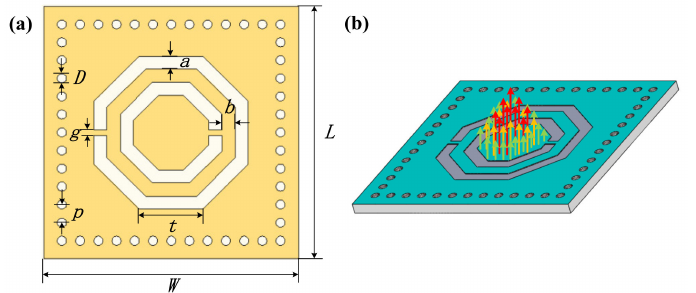
Figure 1. Model of the proposed CSRR integrated sensor. ( a ) The physical and geometric parameters of the CSRR integrated temperature sensor. ( b ) Electric field